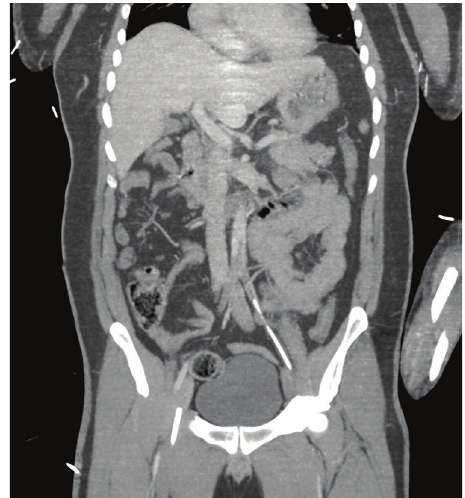
Figure 1: Abdominal CT showed multiple splenic and renal infarcts and a thrombus at the aortic bifurcation extending into the inferior mesenteric artery and into both common iliac arteries.